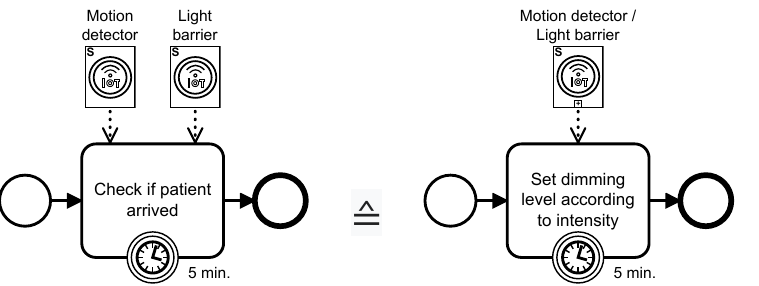
Figure 7. Usage of Catch Artifact and Catch Group Artifact.